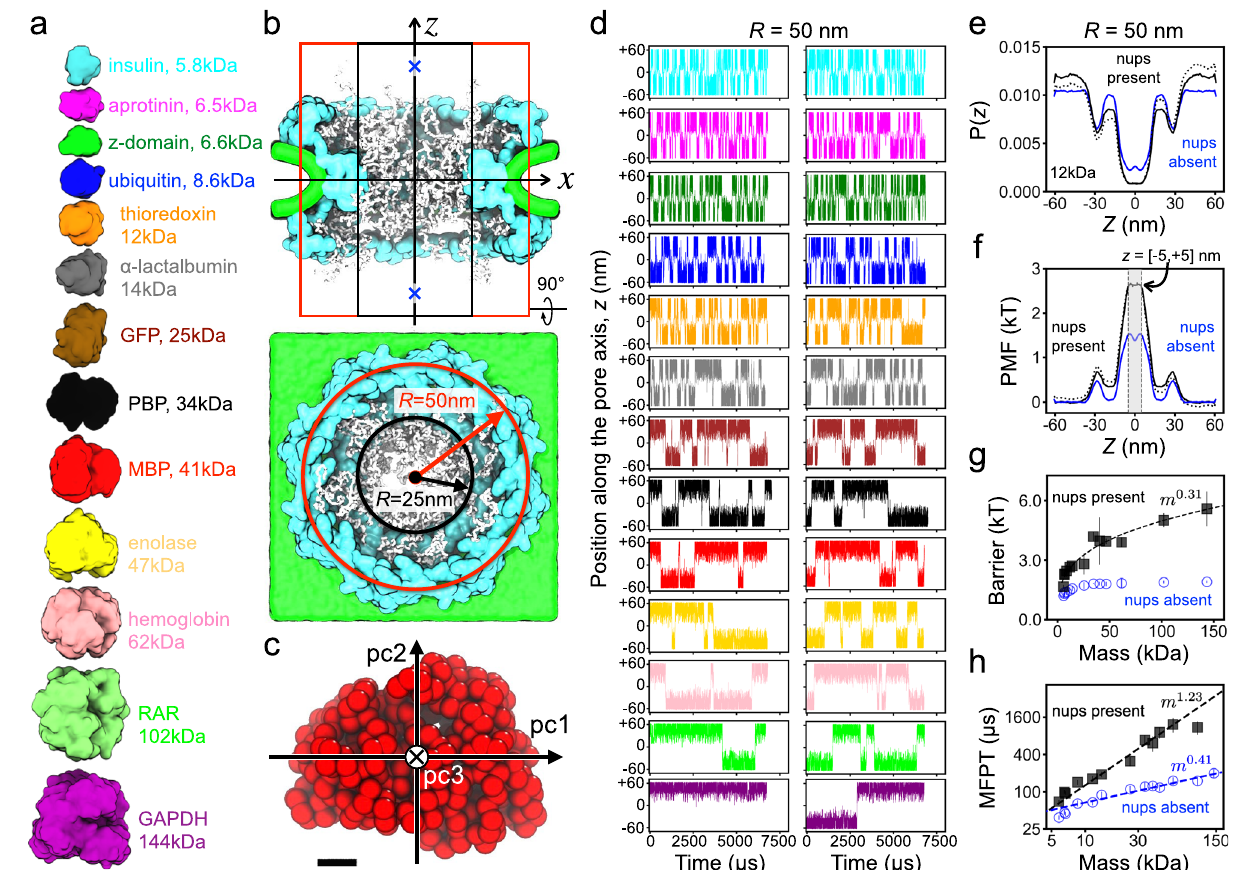
Fig. 2 | CG simulations ofpassive diffusion across the NPC. a To-scale structural representation of all proteins used for CG simulations of passive diffusion. b Side (top) and overhead (bottom) view of the simulation systems. Black and red lines indicate the approximate location of a cylindrical con fi nement potential of 25 and 50nmradius,respectively.Bluecrossesmarkthetwoinitiallocationsoftheprotein (at z =±50nm). c Rigid-bodymodelofamaltose-bindingprotein(MBP)whereeach bead represents one amino acid.Pc1, pc2, and pc3 denote the principalaxes ofthe protein.Blackscalebar,1nm. d Center-of-mass z coordinateofeachprotein(colors de fi ned in panel a ) versus simulation time. The simulation traces in the two col- umnsdifferbytheinitialplacementoftheprotein.Thesimulationswereperformed inthepresenceofa50nm-radiuscon fi nementpotential. e Normalizeddistribution of the CoM z coordinate of thioredoxin. The black dotted and solid lines show the distribution extracted directly from the simulations and the symmetrized dis- tribution, respectively. The blue line shows a symmetrized distribution for the